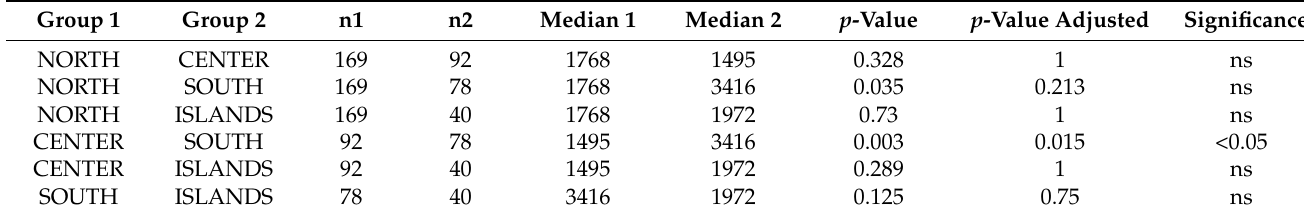
Table 8. Pairwise Wilcoxon rank-sum tests on the number of likes for the area.